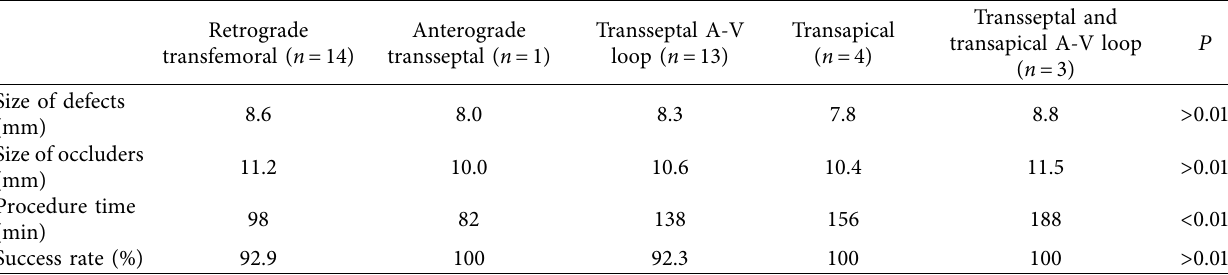
Table 3: Comparison between different